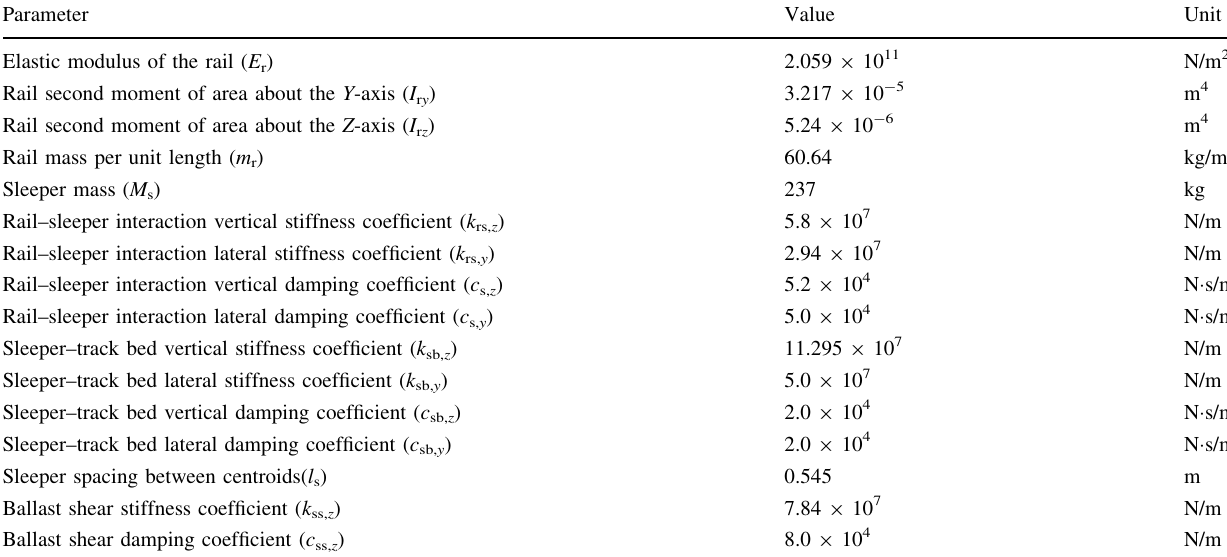
Table 3 The ballasted track parameters